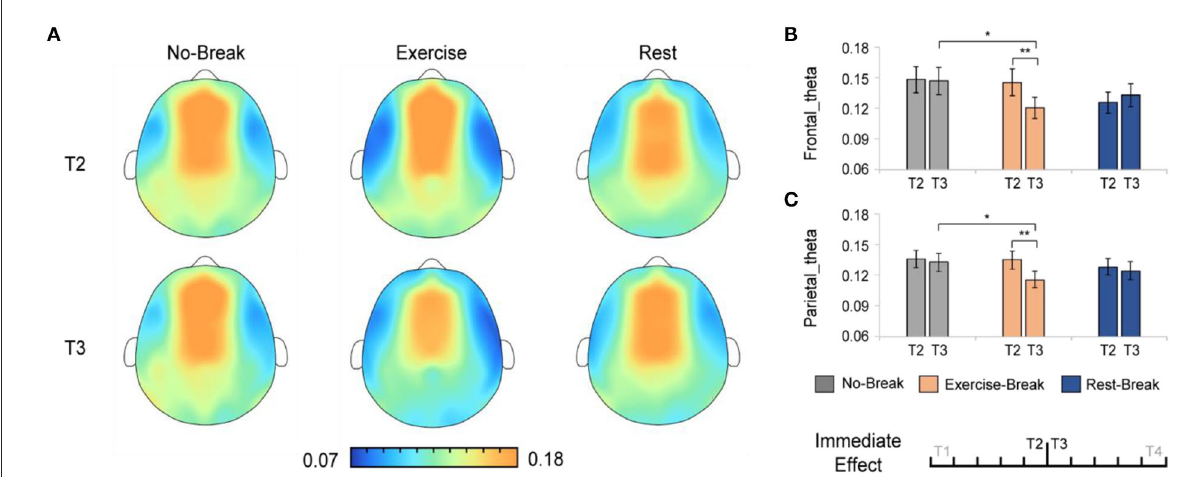
FIGURE4 The theta spectral changes in immediate effect (T2 vs. T3). (A) The brain topography of the immediate effect of the mid-task breaks on theta activities. The EEG power ratios of the (B) frontal and (C) parietal theta in the pre-break bin (T2) and post-break bin (T3). ** p < 0.01; * p < 0.05. Error bars represent the mean ± SEM.